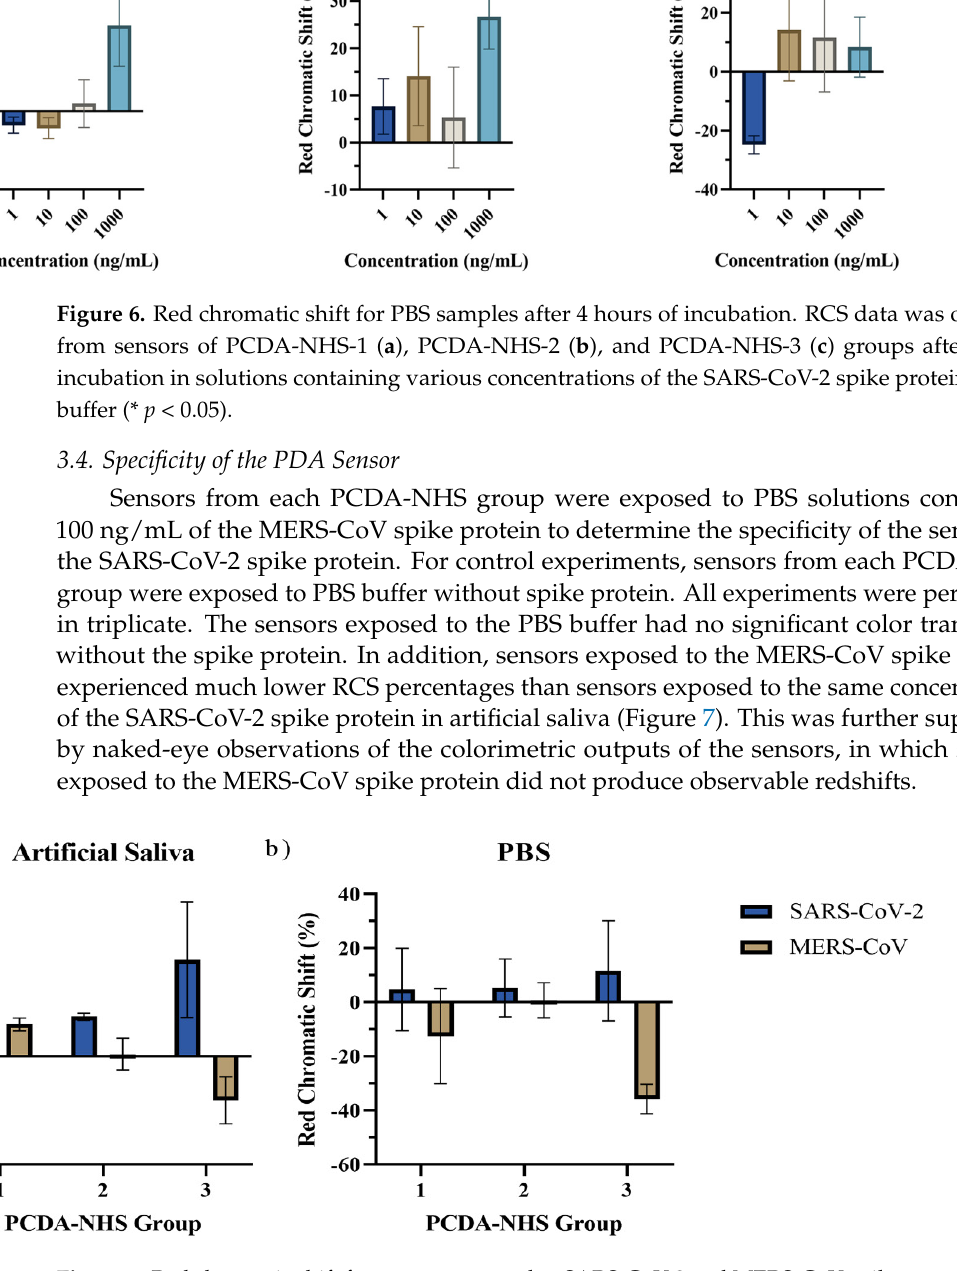
Figure 7. Red chromatic shift for sensors exposed to SARS-CoV-2 and MERS-CoV spike proteins. RCS data was obtained from sensors of each PCDA-NHS group after 4 h of incubation in artificial saliva ( a ) and PBS ( b ) solutions containing 100 ng/mL SARS-CoV-2 spike protein or 100 ng/mL MERS-CoV spike protein. Sensors exposed to the MERS-CoV spike protein did not produce colorimetric shifts discernible by the naked eye.